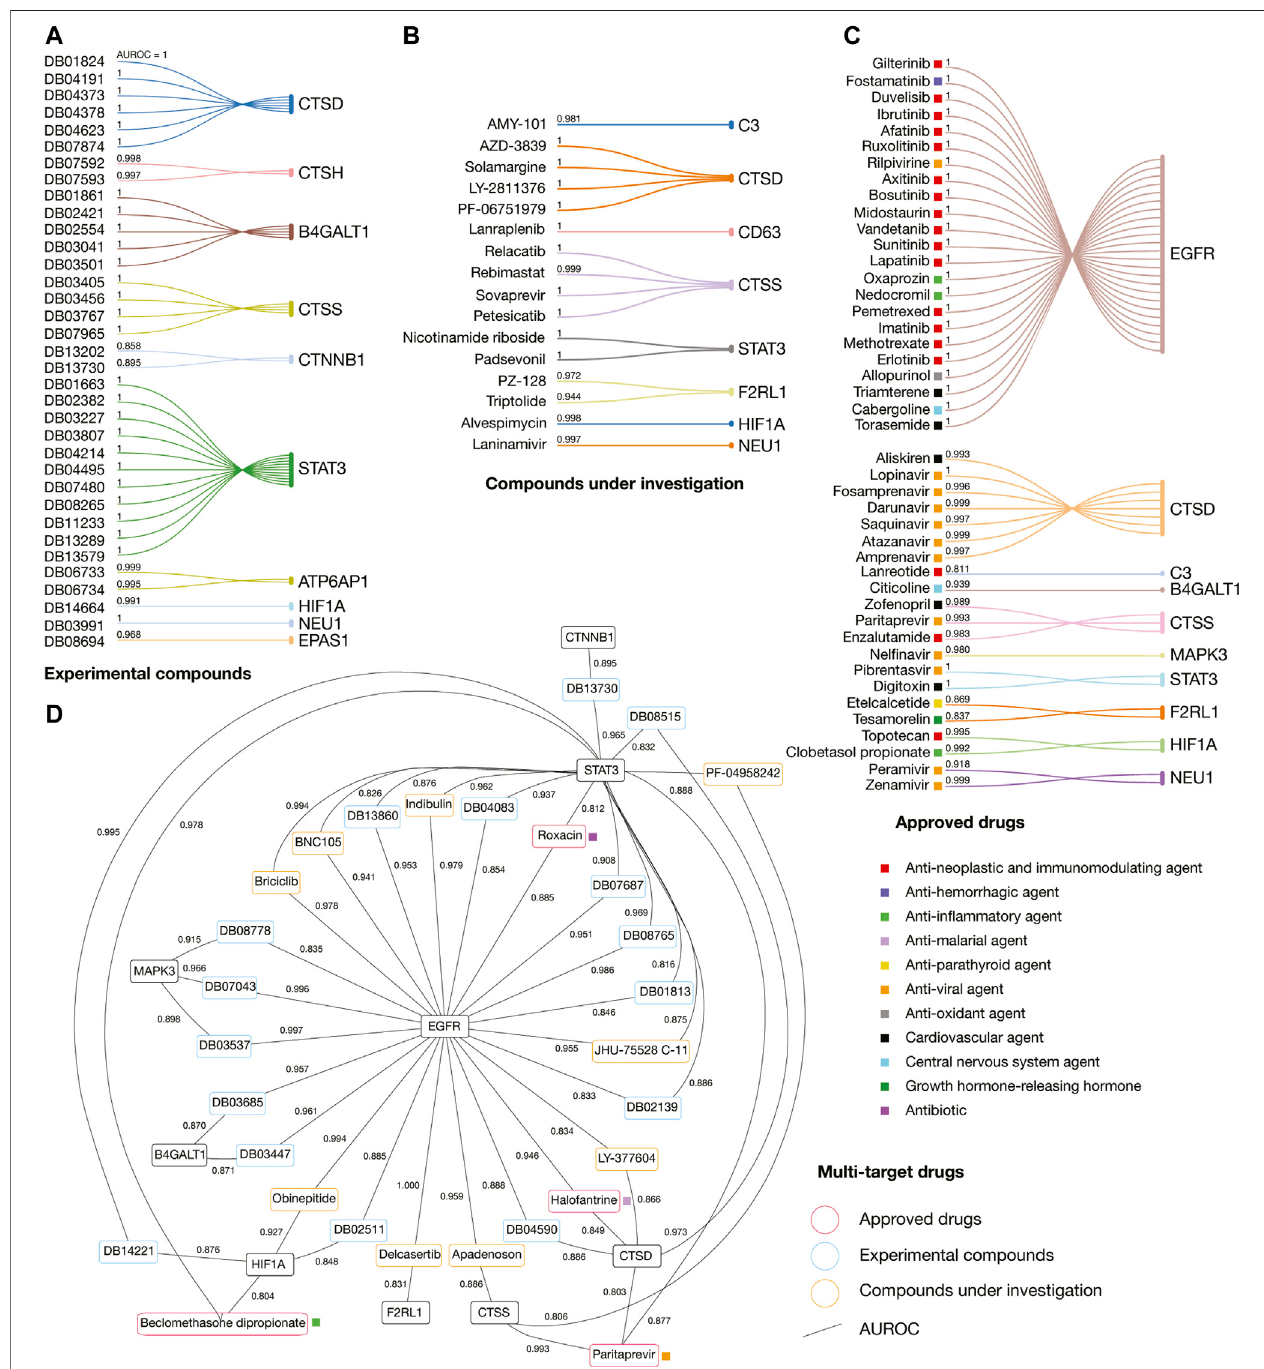
FIGURE 8 | Drug repurposing analyses applying arti fi cial neural networks. (A) Best-predicted experimental compounds per immune system protein target. (B) Best-predicted compounds under investigation per immune system protein target. (C) Best-predicted approved drugs per immune system protein target. (D) Best- predicted multi-target experimental compounds, compounds under investigation, and approved drugs. AUROC: Area under the receiver operating characteristic.